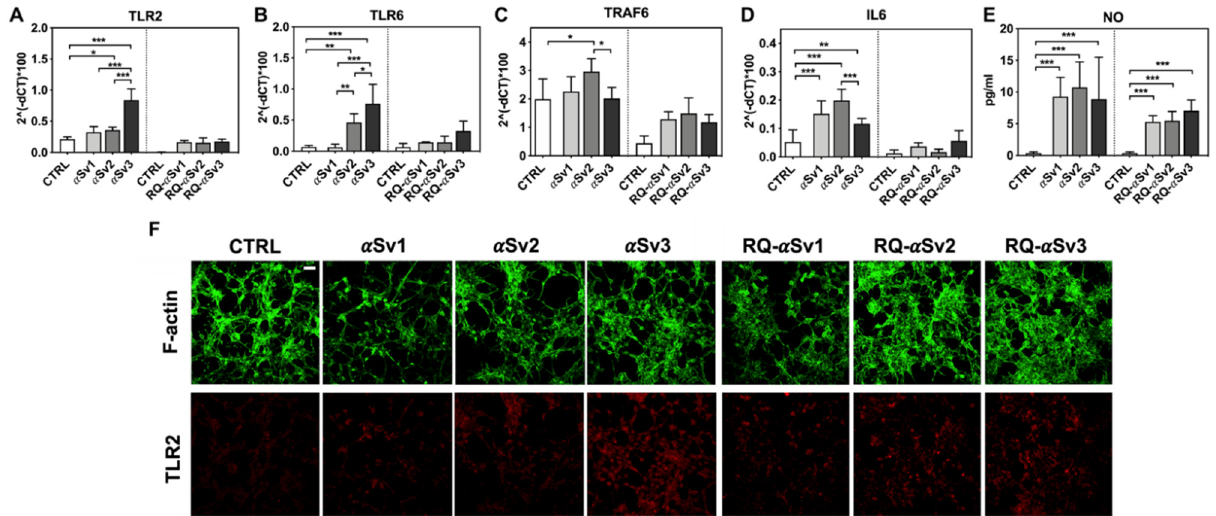
Figure 6. Analysis of inflammatory molecules in differentiated SH-SY5Y cells stimulated with α Sv1, α Sv2, α Sv3 and their α Syn_RT-QuIC reaction products (RQ- α Sv1, RQ- α Sv2, and RQ- α Sv3). RT-qPCR analysis of TLR2 ( A ), TLR6 ( B ), TRAF6 ( C ), IL6 ( D ) showed an upregulation of the inflammatory mediators transcript levels in cells stimulated with α Sv1, α Sv2, α Sv3 but not in those stimulated with RQ- α Sv1, RQ- α Sv2, and RQ- α Sv3. ( E ) NO quantification in the supernatants of cells stimulated with α Sv1, α Sv2, α Sv3, RQ- α Sv1, RQ- α Sv2, and RQ- α Sv3 and related control buffers. A significant increase in NO release was found only in α Sv1, α Sv2, α Sv3, RQ- α Sv1, RQ- α Sv2, and RQ- α Sv3 stimulated cells. Values are expressed as mean ± SD. Statistical significance was assessed by one-way ANOVA test with Dunnett’s multiple comparison test. Corrected p -values are reported in the results section. * p ≤ 0.05, ** p ≤ 0.01, *** p ≤ 0.001. ( F ) Immunofluorescence analysis of TLR2 expression (red) in SH-SY5Y treated cells or in control condition showing an increase in protein expression in all SH-SY5Y stimulated cells that was more intense in those challenged with α Sv3. Counterstaining with Alexa-Fluor 488-Phalloidin (green) was performed to monitor the cytoskeleton structure. Bar scale = 25 µ